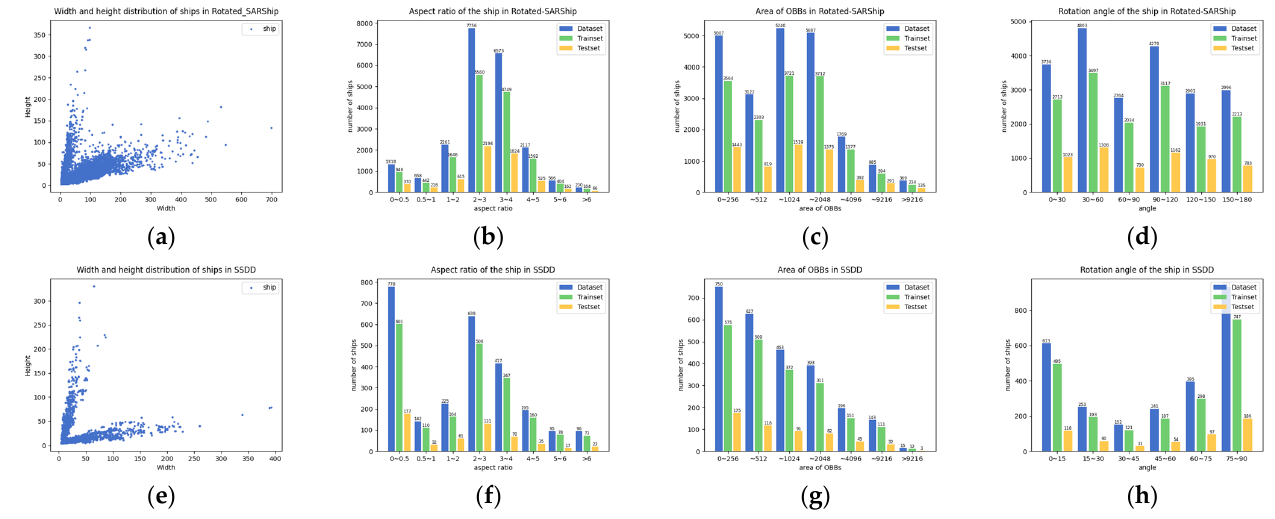
( h ) Figure 16. Ship ground truth annotations of diverse SAR images in RSSD. Real ships are accurately marked in green OBBs. ( a ) Offshore single ship; ( b ) offshore multiple ships; ( c , d ) densely arranged ships; ( e ) ships lying off the port; ( f ) ships with large aspect ratios; ( g , h ) small ships in the canal. 5.4. Statistical Analysis on the RSSD Figure 17 visualizes the comprehensive statistical comparison between our RSSD and SSDD, both of which adopt OBB annotations. As Table 3 shows, 70% of the RSSD images are randomly selected as the training set, and 30% are selected as the test set. For the SSDD, we divide all images in the ratio of 8:2 according to [28]. As shown in Table 1, SSDD con- tains 1160 SAR images with 2587 annotated ships, indicating that each image contains only 2.2 ships on average, while in our dataset, each image contains about 2.7 ships. Figure 17a,e display the width and height distribution of ship ground truths. Compared to the extreme funnel-like distribution of SSDD, our RSSD features a more uniform ship size